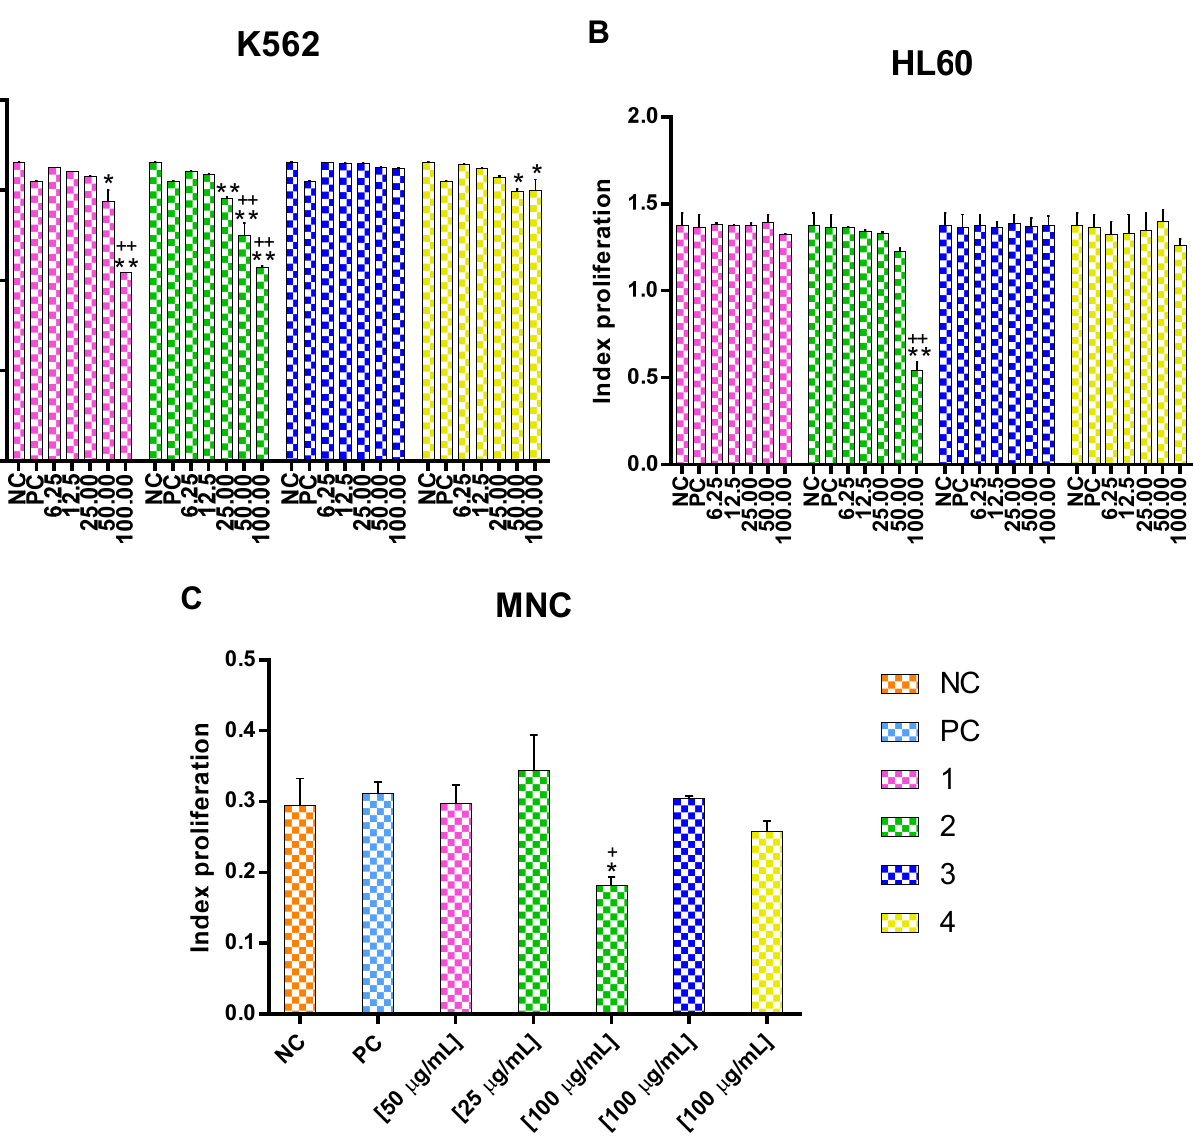
Figure 3. The data represent mean ± SEM of proliferation index from three different experiments K562 ( A ), HL60 ( B ) cell lines and normal MNC ( C ) at different concentrations. * p < 0.05 and ** p < 0.01 were compared to the negative control. + p < 0.05 and ++ p < 0.01 were compared to the positive control. Statistical significance was determined by a one-way analysis of variance (ANOVA) followed by Dunnett’s post-hoc test .